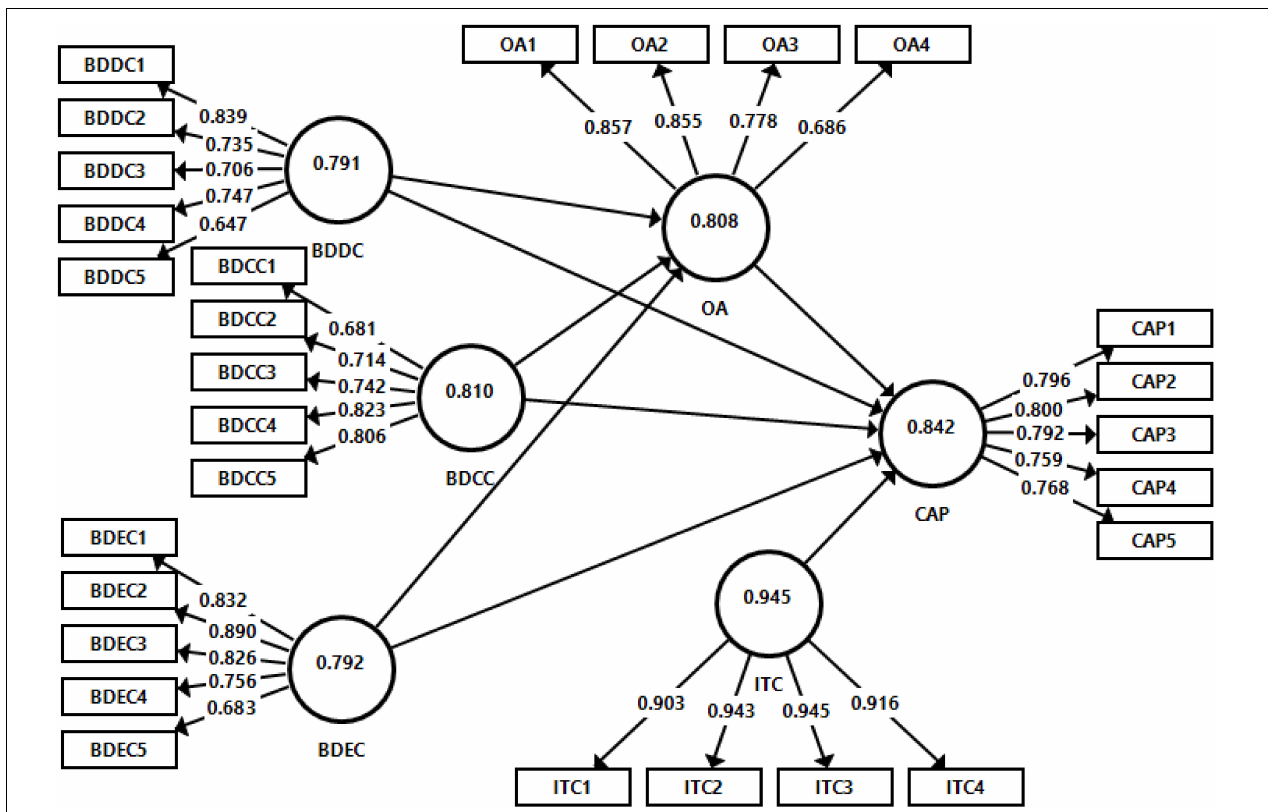
FIGURE 1 | Measurement model